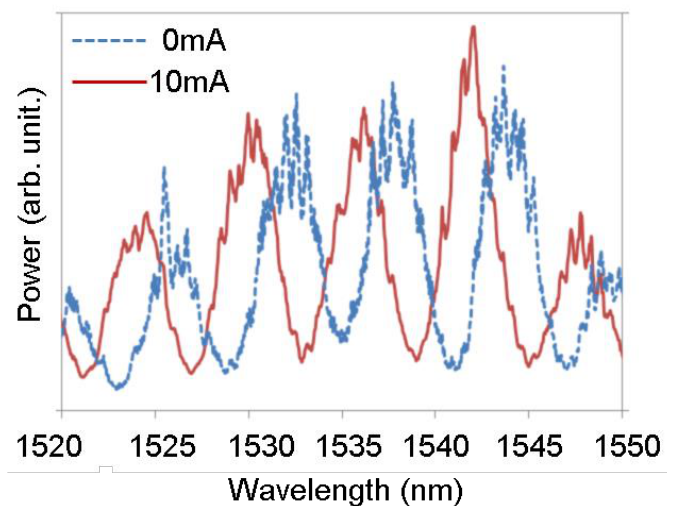
Figure 8. Shift in transmission spectrum of an MZI-based modulator with an MMI phase modulator caused by current injection.